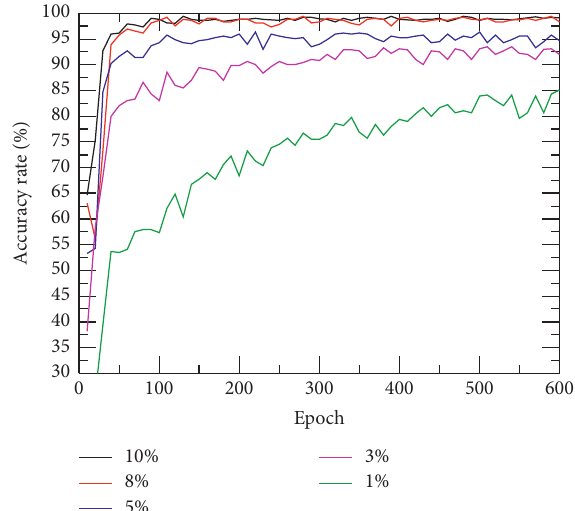
Figure 11: Accuracy of different labeled samples with iteration